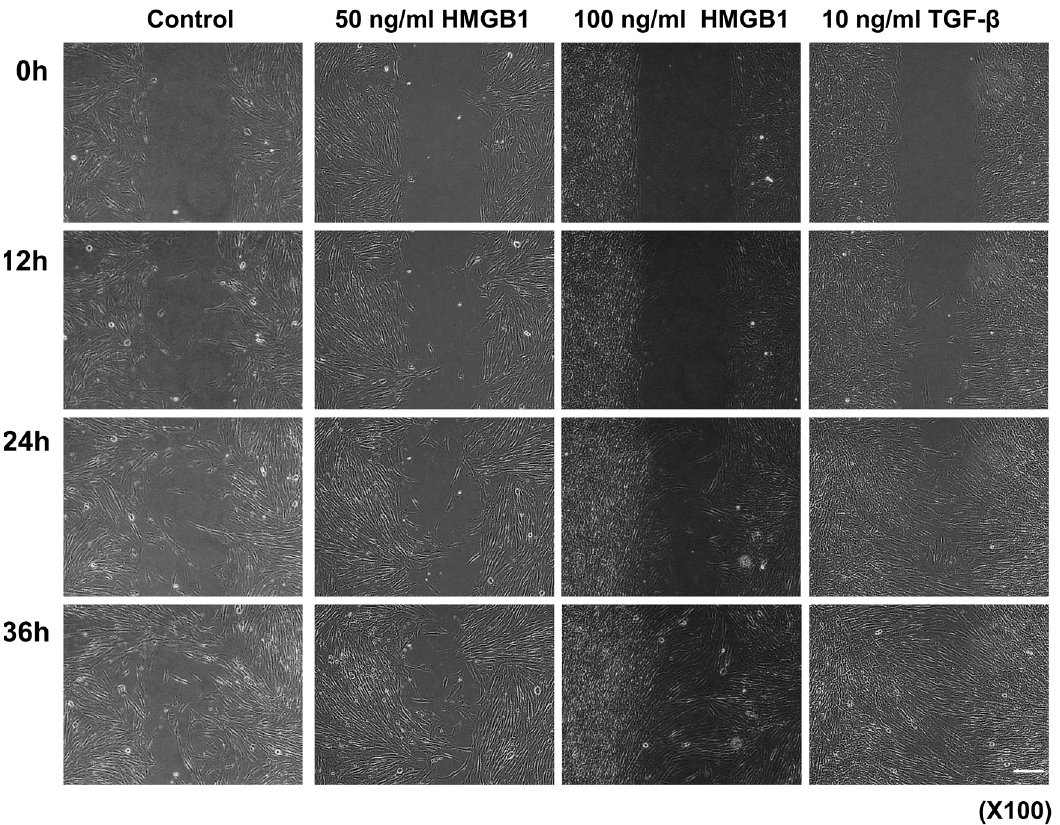
Figure 1. In vitro wound healing assay and cell-tracking system for cell migration. Scale bar: 50 μ m. Recovery of the denuded space was completed after 36 h in normal fibroblasts. However, the wound area on the 50 ng/mL and 100 ng/mL High-mobility group box 1 (HMGB1)-treated and 10 ng/mL TGF- β -treated groups showed more rapid closure than the untreated control group.